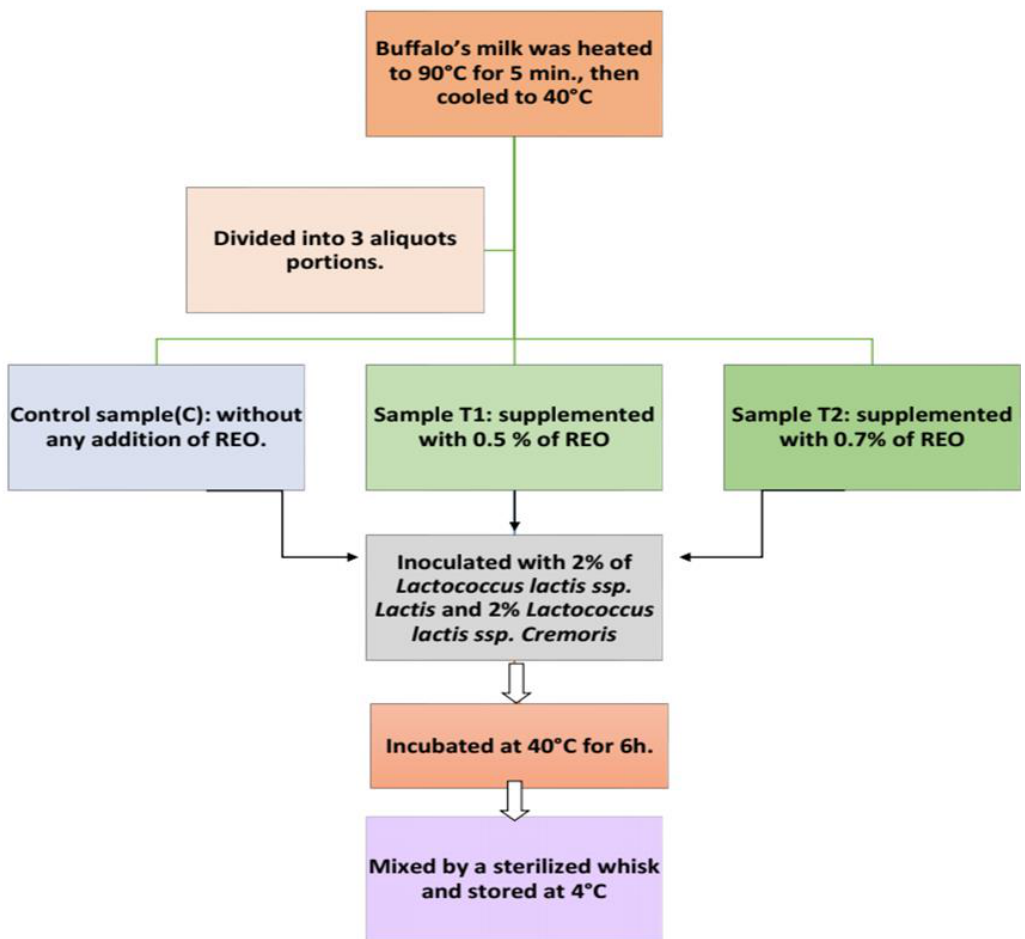
Figure 1. Flow sheet diagram for making SLY supplemented with 0.5 and 0.7% of REO.